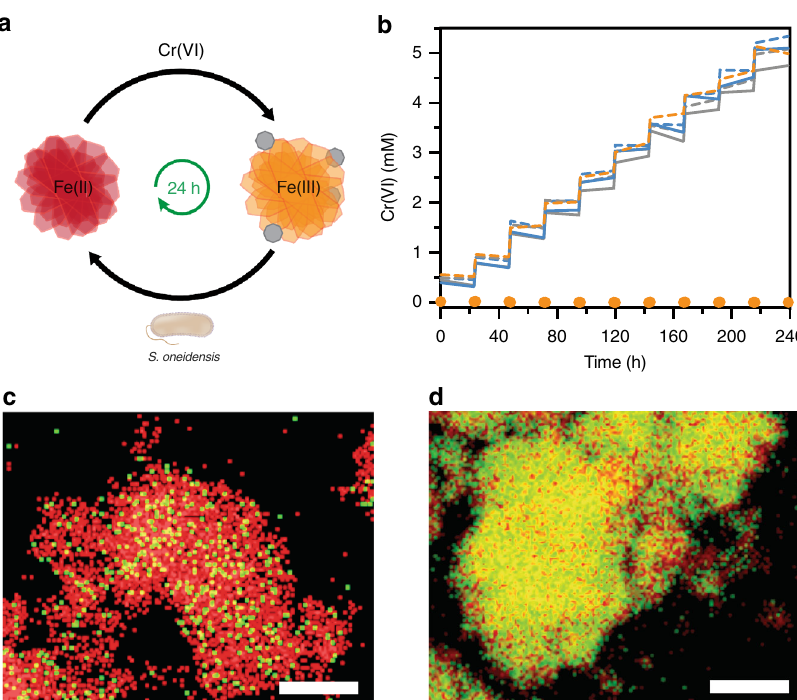
Fig. 6 Cr(VI) cycling with reduced metal-organic frameworks. a Generalized scheme for Cr(VI) cycling where S. oneidensis regenerates Fe(II) following Cr (VI) additions. b Cr(VI) removal in S. oneidensis MR-1-reduced MIL-100 (orange), ferrihydrite (gray) and fumarate (blue) when challenged with ten cycles of 0.5 mM Cr(VI). Abiotic samples are shown as dashed lines. c , d EDX element mapping of ( c ) abiotic cycled MIL-100 and ( d ) S. oneidensis MR-1-reduced and cycled MIL-100. Fe is shown in red and Cr is shown in green. Scale bars are 1 µ m. Data show mean ± S.D. for three independent replicates. Source data for b are provided as a Source Data fi